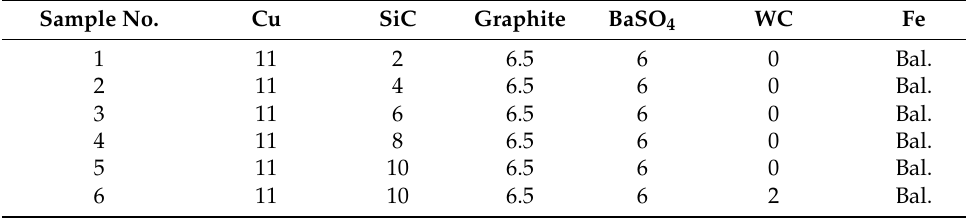
Table 1. Volume fraction of different phases in composite samples. Sample